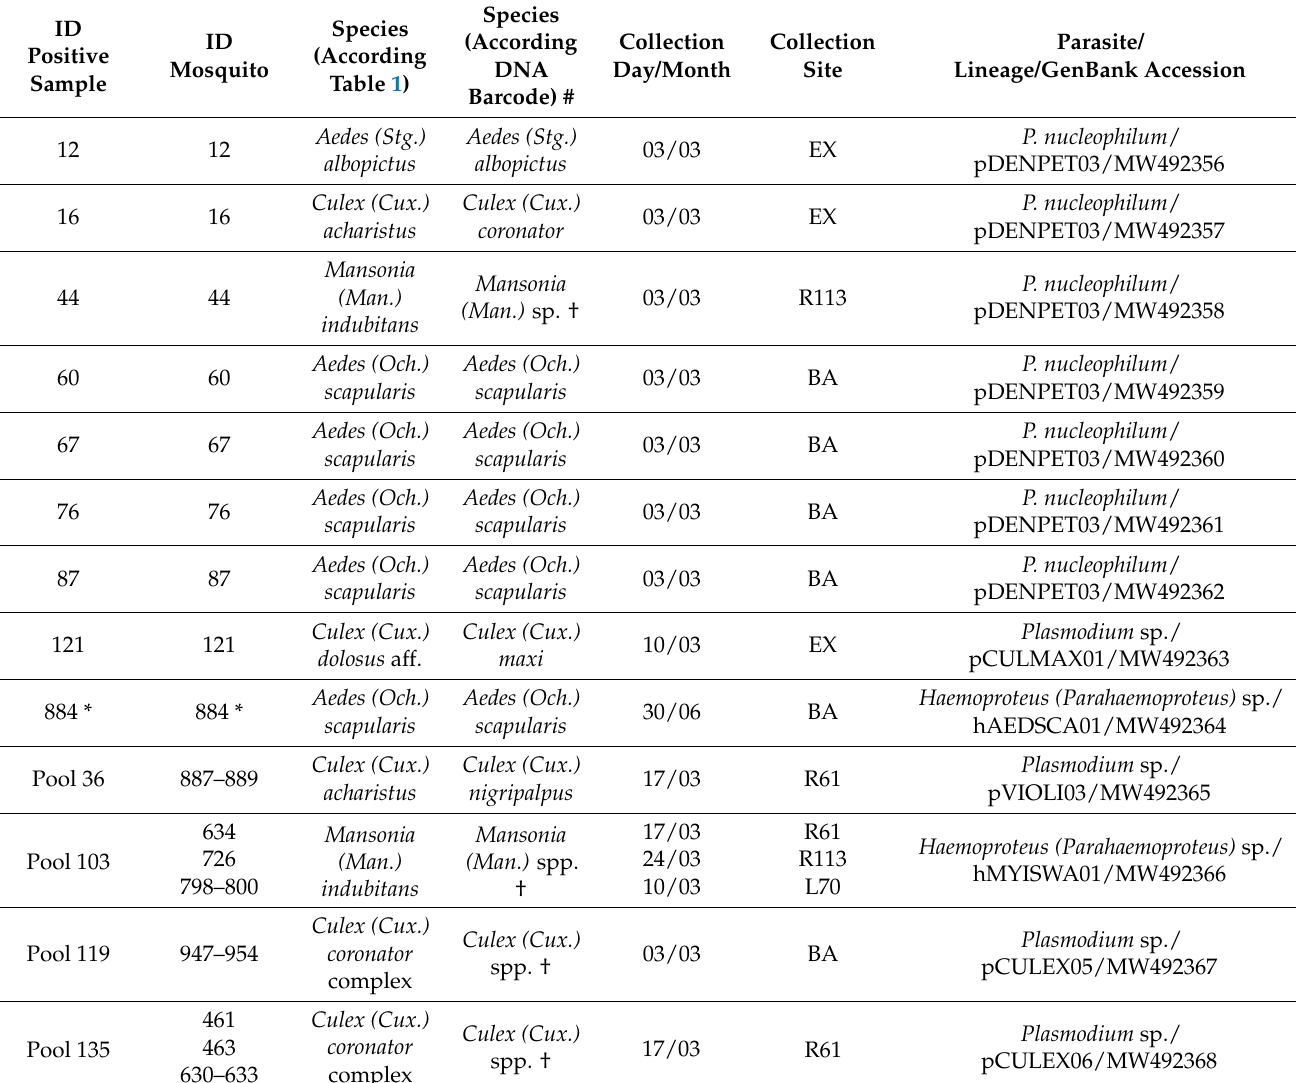
Table 2. Data of the haemosporidian positive